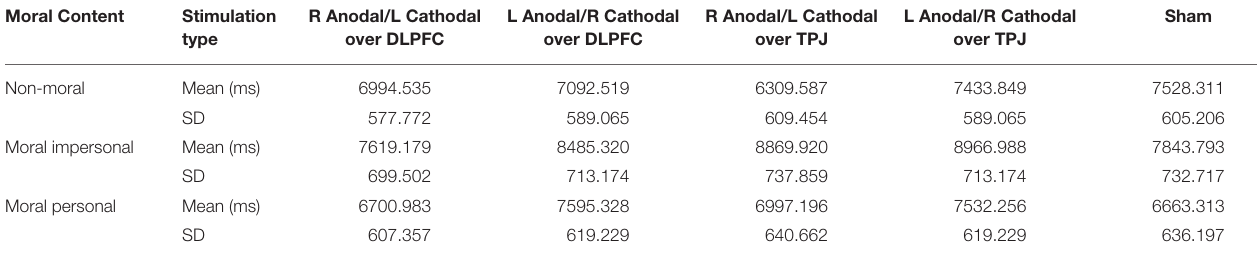
TABLE 1 | The mean and SD of reaction time across moral contents and stimulations. Moral